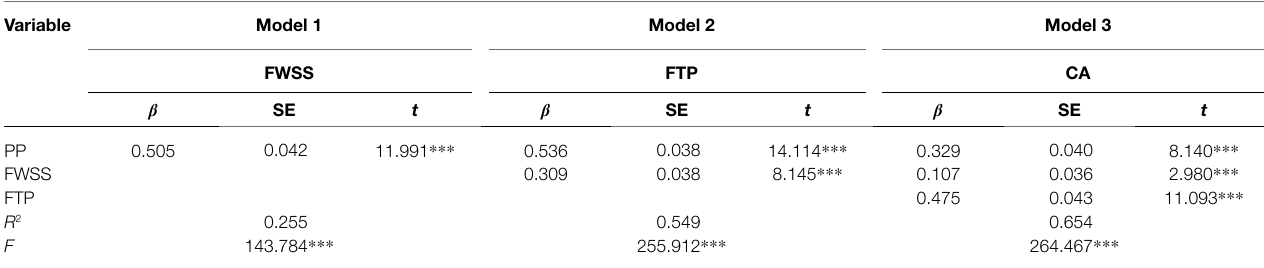
TABLE 3 | The model results ( N =